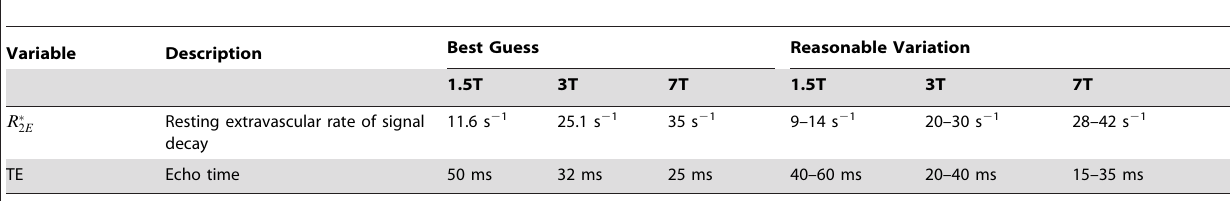
Table 2. Input parameter to the detailed model that are sensitive to B 0